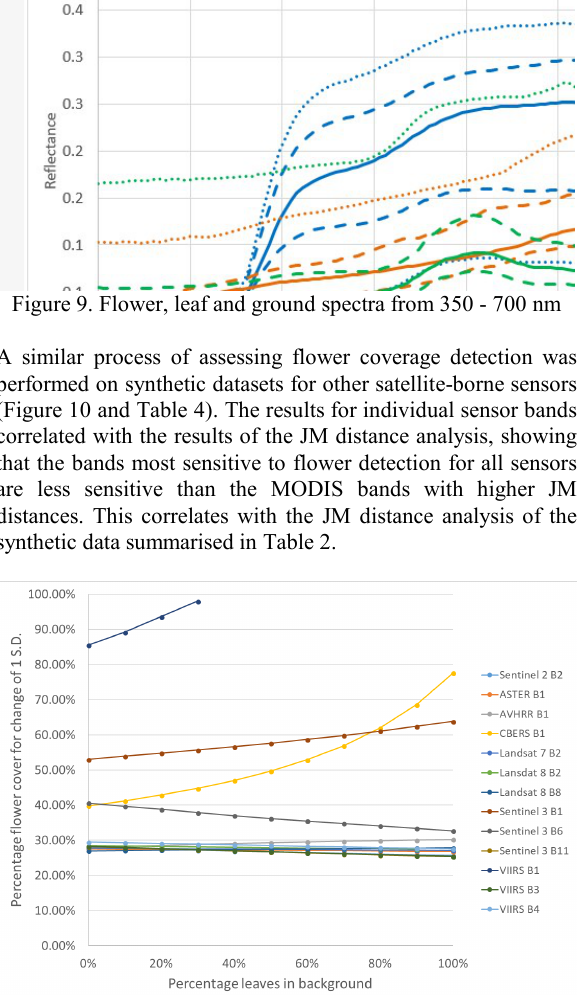
Figure 10. Percentage cover of flowers require to change the reflectance by 1 standard deviation for different background ratios of ground and leaves for other sensors and satellites Where satellites had UV and near-UV bands (Band 1 for both Sentinel 3 and VIIRS), the same indices were calculated as were done for the MODIS data (visible band divided by the UV or near-UV band). The results of this, shown in Figure 11 and Table 4, show greater sensitivity to flower detection at low flower coverages than visual band data alone, producing detection limits more sensitive to flower coverage than when sensitivity was from Sentinel 3 (Band 6 / Band 1), with a mean flower coverage of just 1.1% required to make a difference of 1